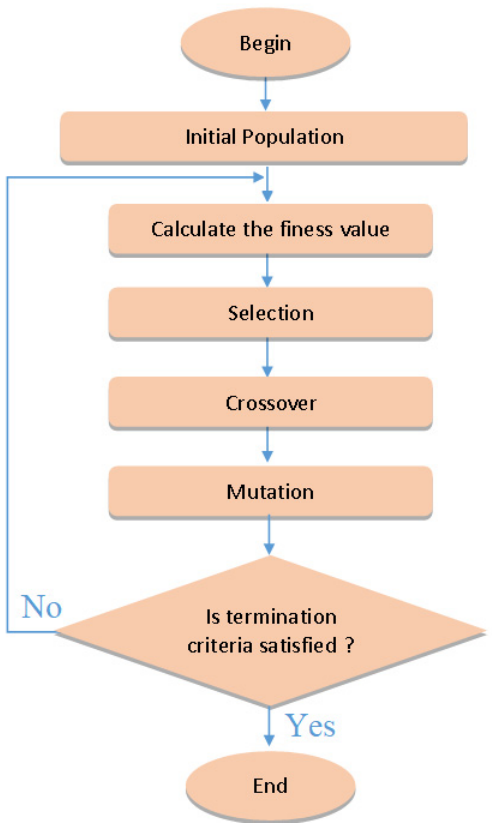
Figure 4. Genetic algorithm diagram.